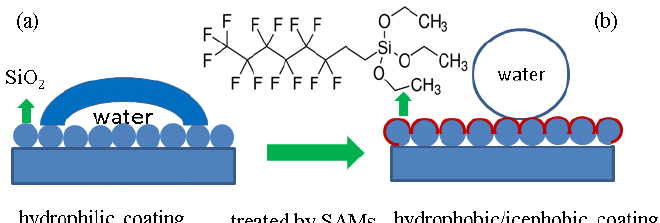
Figure 2. The schematic of the surface modification process by self-assembled monolayers and conversion from hydrophilic ( a ) to super-hydrophobic ( b ).